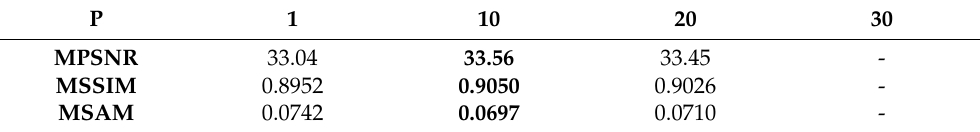
Table 6. Effect of orthogonal subspace dimension P on Washington DC data with mixture noise.